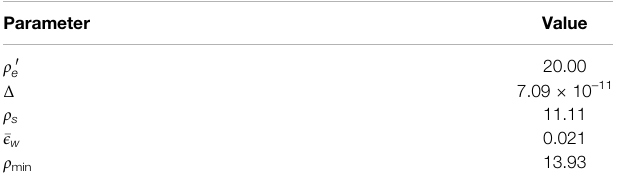
TABLE 8 | Equation 86 parameters from the third set of parameters for CSTR model in Table 7